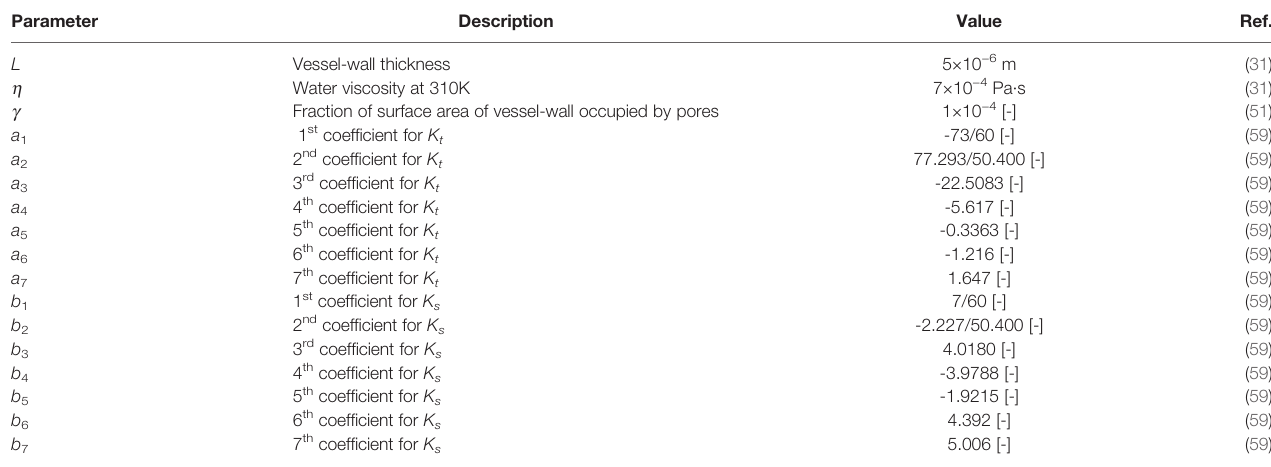
TABLE 5 | Parameter values used for NP-related